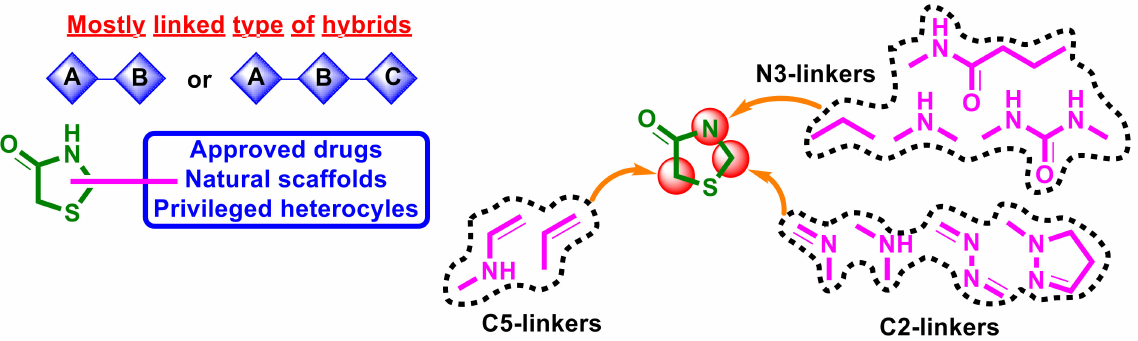
Figure 29. Schematic presentation of empirical SAR for 4-thiazolidinone-bearing hybrid molecules with anticancer